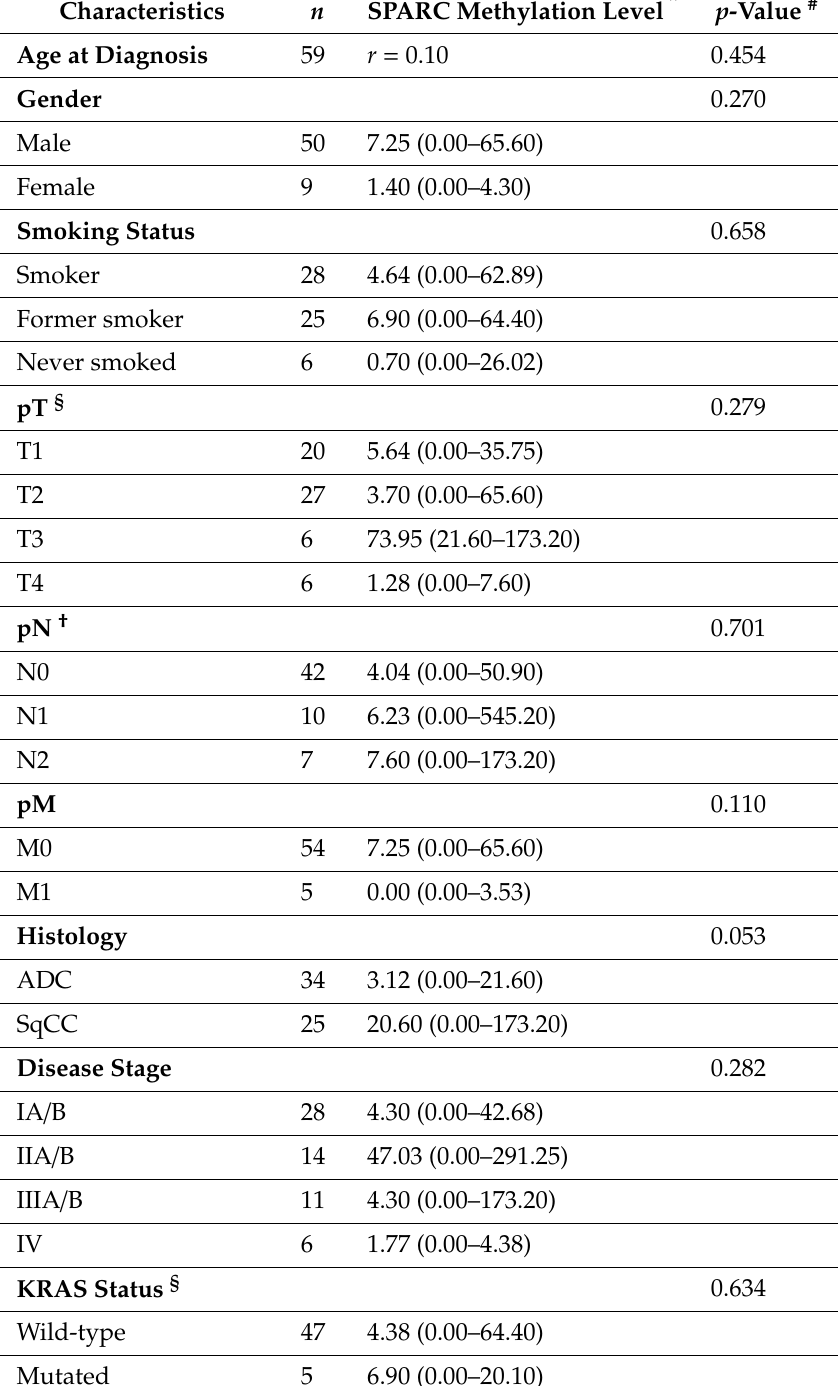
Table 3. Distribution of SPARC methylation levels by NSCLC patients’